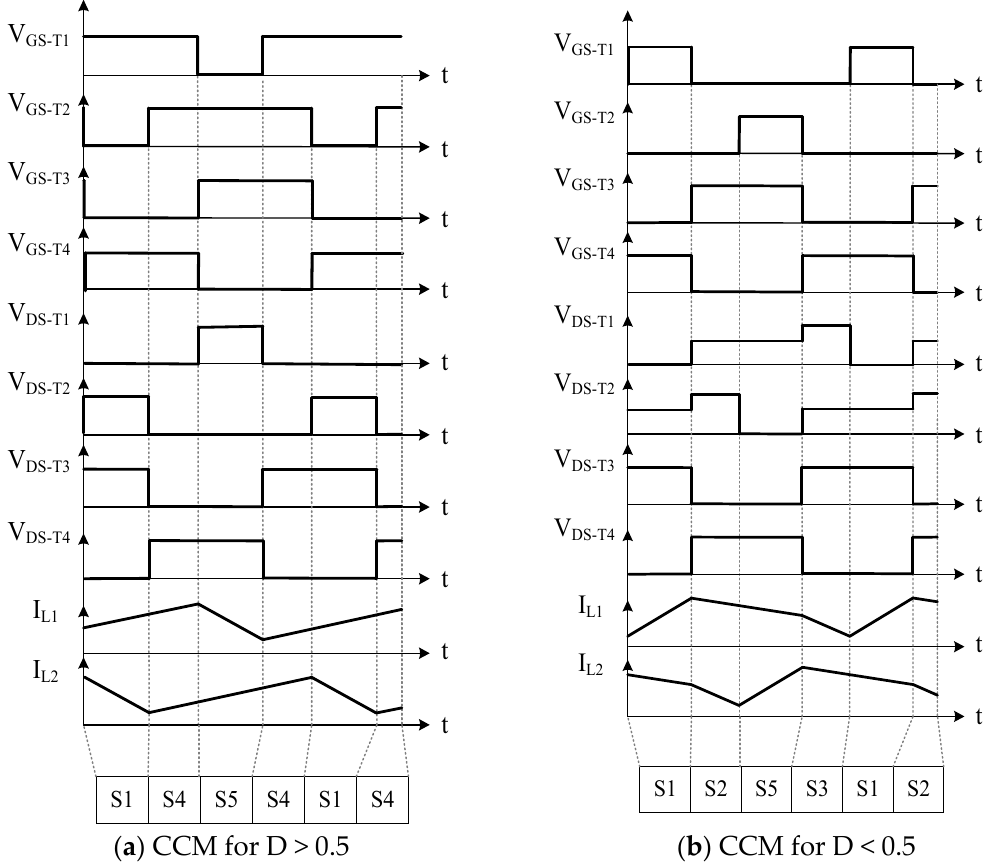
Figure 2. Presumptive functioning waveform and switching stages correlations. V GS-T1 , V GS-T2 , V GS-T3 and V GS-T4 —Gate-Source voltage for T 1 –T 4 transistors; V DS-T1 , V DS-T2 , V DS-T3 and V DS-T4 —Drain-Source voltage for T 1 –T 4 transistors; I L1 and I L2 –L 1 and L 2 inductor currents; D—Duty Cycle; CCM—continuous conduction mode; S1–S5—switching stages from Figure 2.